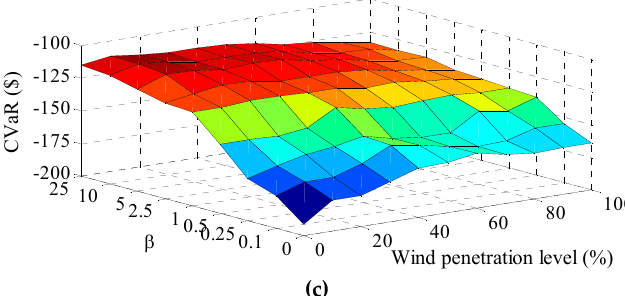
Figure 5. Impact of wind power penetration level at different values of β on ( a ) expected profit, ( b ) cost of generation, and ( c ) CVaR.